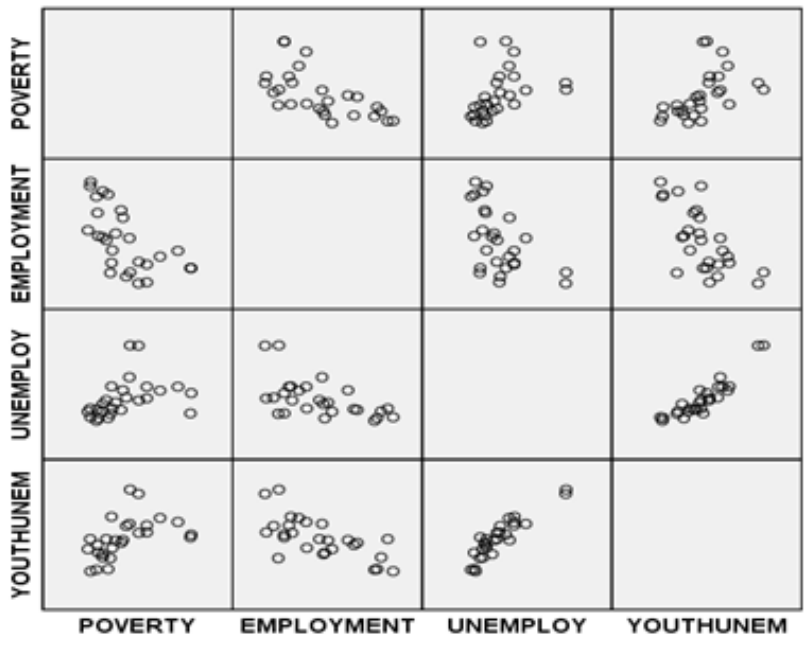
Figure 4 – Scatterplot matrix of the four variables